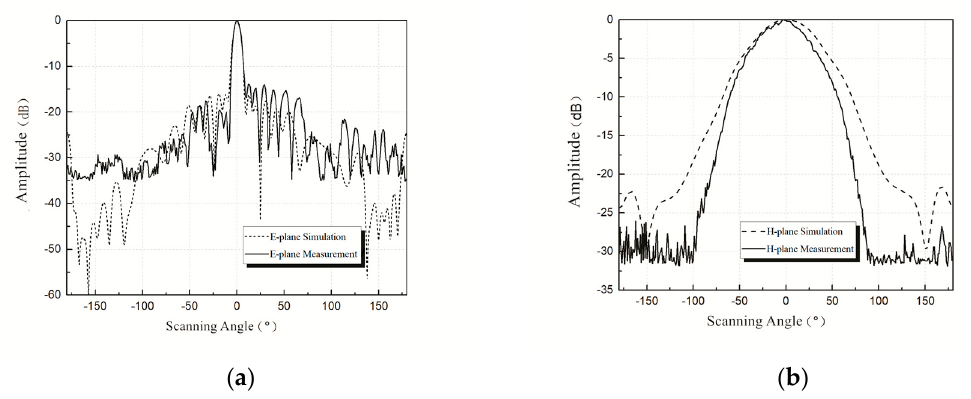
Figure 8. ( a ) Simulation and measurement results on E -plane of "1011111111" patch array antenna; ( b ) simulation and measurement results on H -plane of "1011111111" patch array antenna.